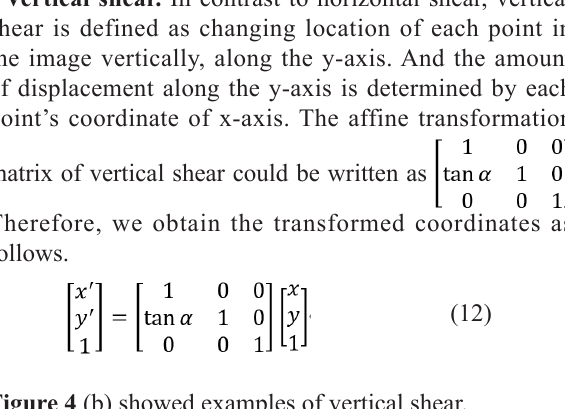
Figure 4 (b) showed examples of vertical shear. Rotation. Like its name, it rotates an image around a fixed point. In most cases, rotation is around the central point of the image in data augmentation. The affine